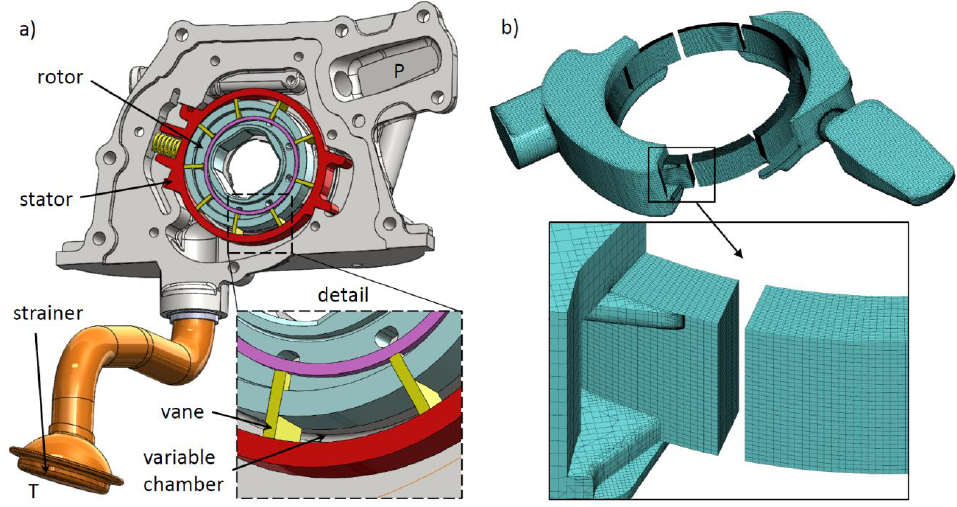
Figure 1. ( a ) Three-dimensional view of the vane pump with the detail of a variable chamber; ( b ) Computational domain with a detail of the mesh resolution. ( b ) Computational domain with a detail of the mesh